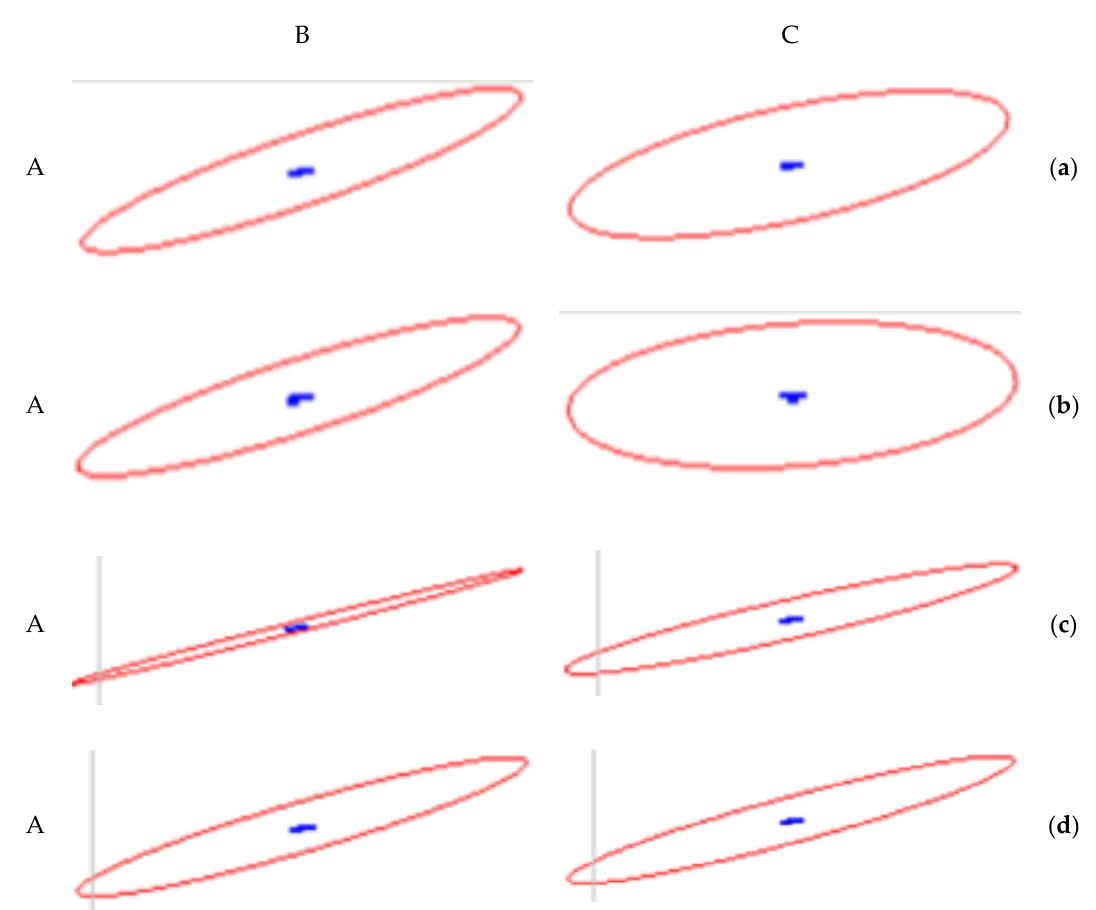
Figure 6. Correlation between the measured noise level (A) and vehicles: passenger cars (B) and trucks (C), where: ( a ) road A1; ( b ) road A5; ( c ) road A8; ( d ) road A10.